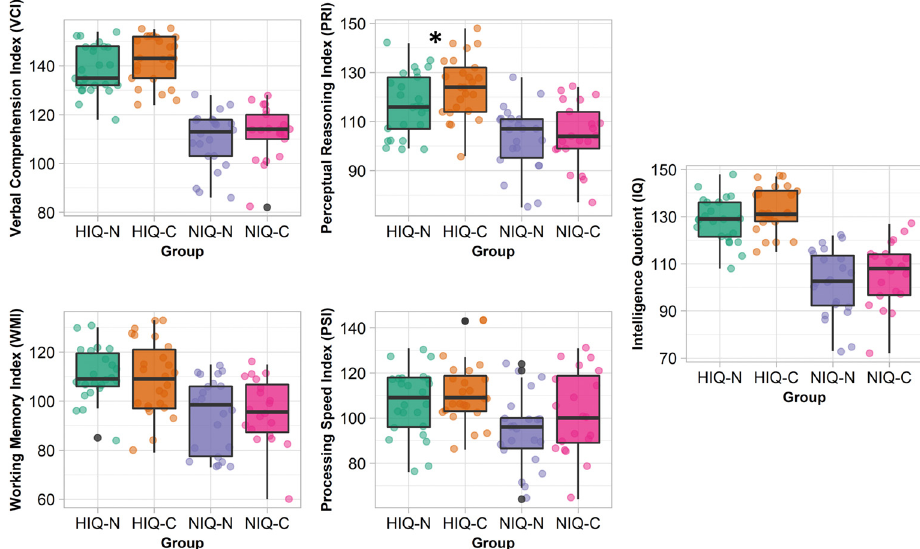
Figure 2. Verbal comprehension index (VCI), perceptual reasoning index (PRI), working memory index (WMI), processing speed index (PSI) and intelligence quotient (IQ) of the Weschler Intelligence Scale for Children (WISC) in each group (green: HIQ-N, orange: HIQ-C, purple: NIQ-N, and pink: NIQ-C). The central line of the boxplots represents the median of each score, the upper and lower parts represent the first and third quartiles. Each point represents the score of one child. Significant differences between groups of the same IQ range (HIQ-N vs. HIQ-C and NIQ-N vs. NIQ-C) are represented by a star: * p < 0.05.